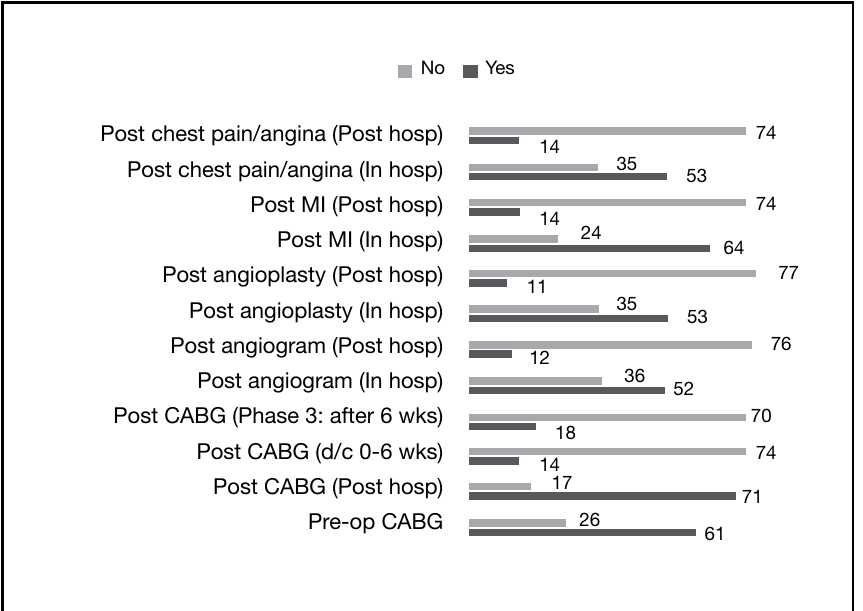
Figure 2: clinical settings and scenarios.